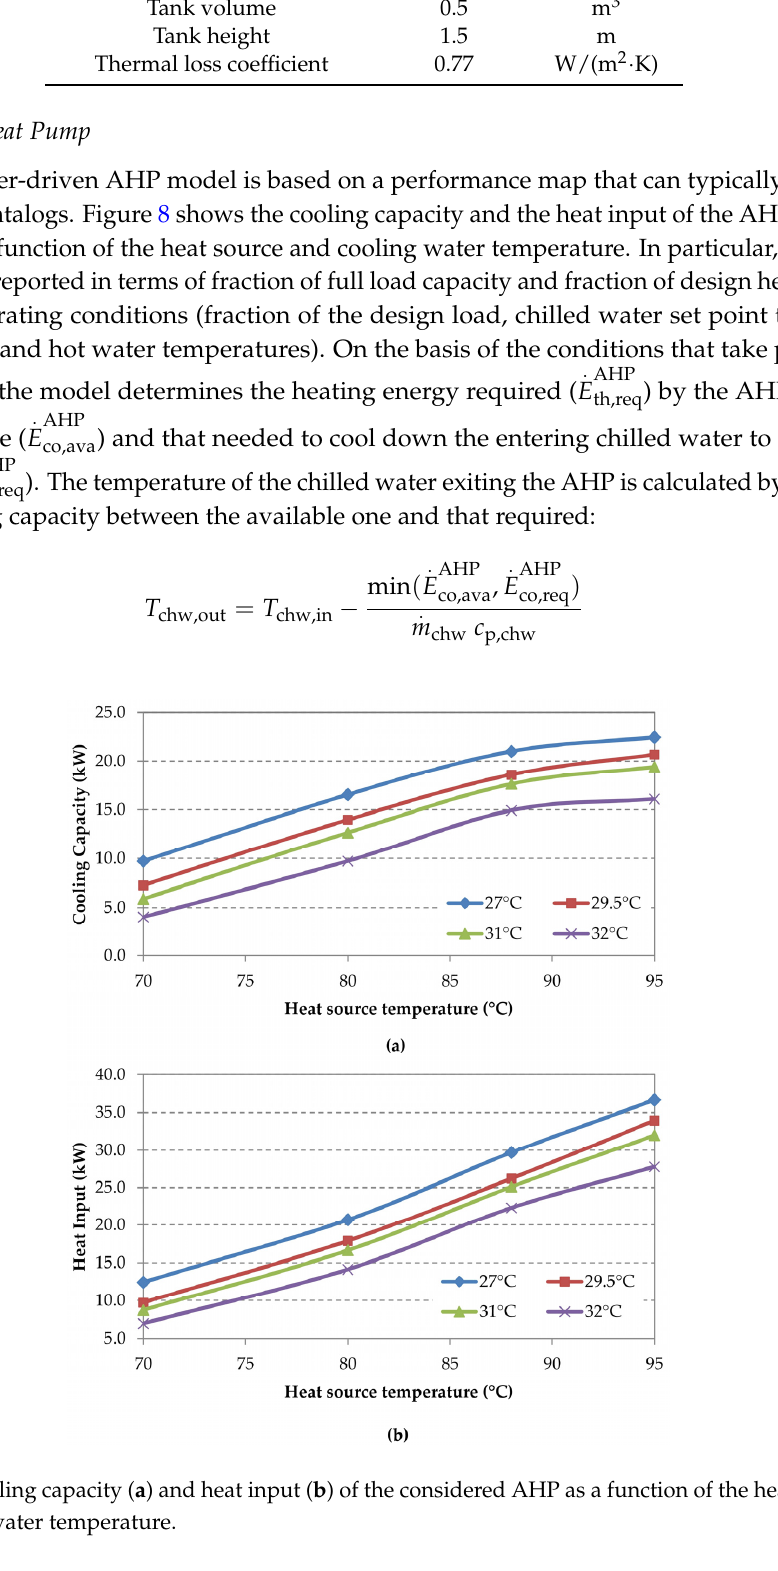
Table 6. Cold water storage tank (CST) parameters.